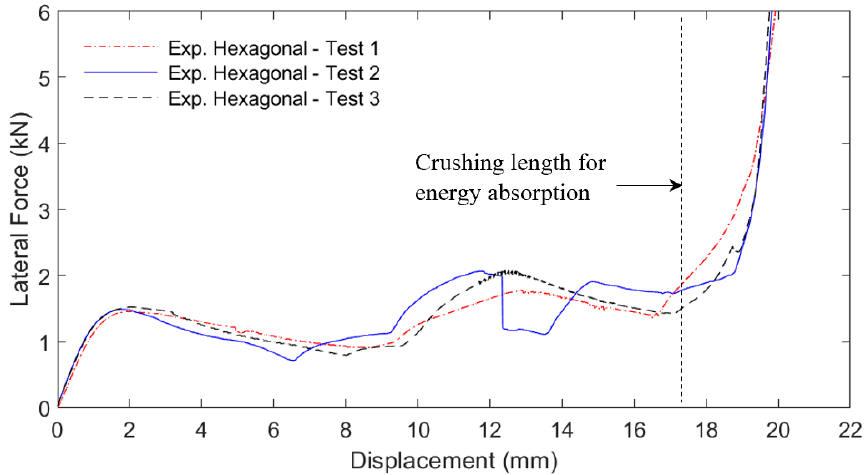
Figure 20. Experimental load vs. displacement curves for hexagonal cell under lateral load.